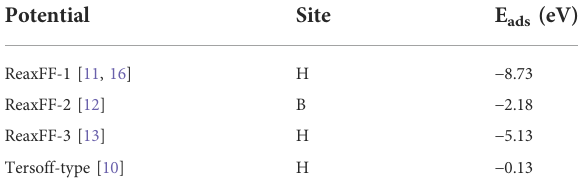
TABLE2Adsorptionenergyandpreferredbindingsiteforinvestigated MD